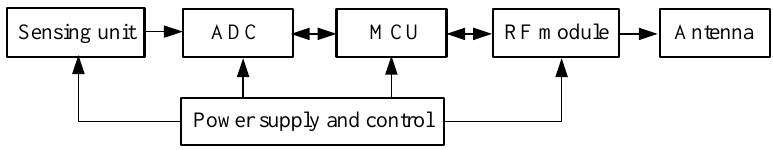
Figure 2. An active RFID sensor network node model.